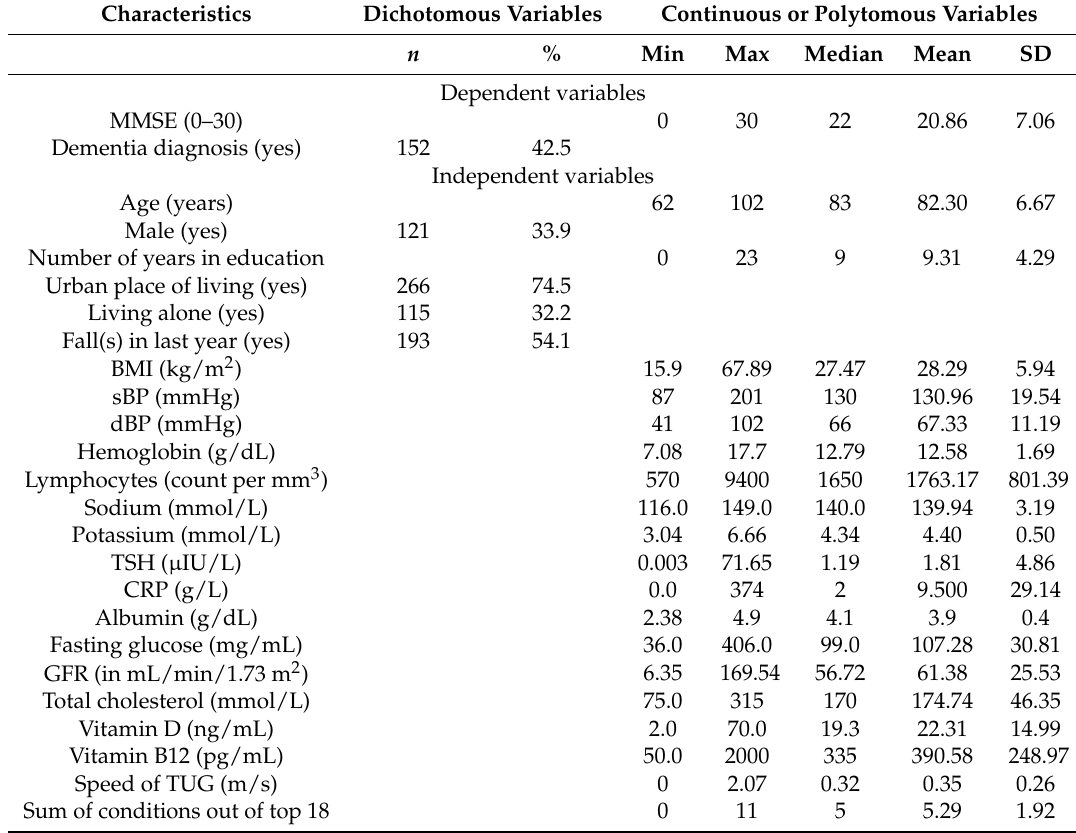
Table 1. Sociodemographic and health-related characteristics of geriatric inpatients ( n = 357).